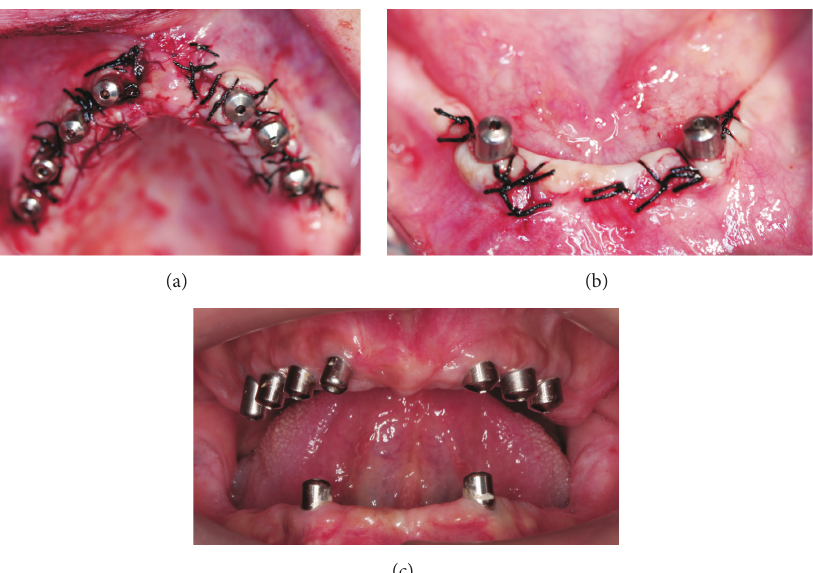
Figure 4: (a and b) Gingival formers were fastened and the flaps were repositioned with interrupted 3.0 silk sutures. (c) The healing was uneventful for the following ten days.